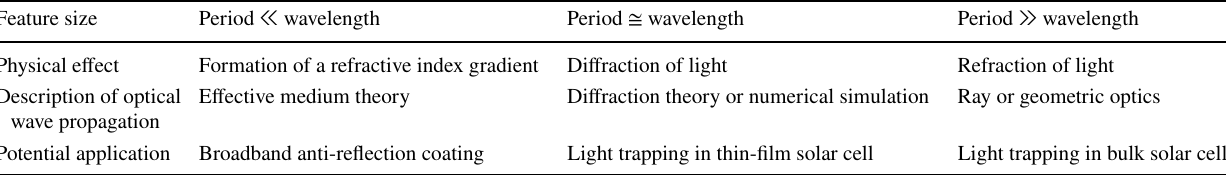
Table 1 Optical wave propagation and photon management mechanisms in solar cells Feature size